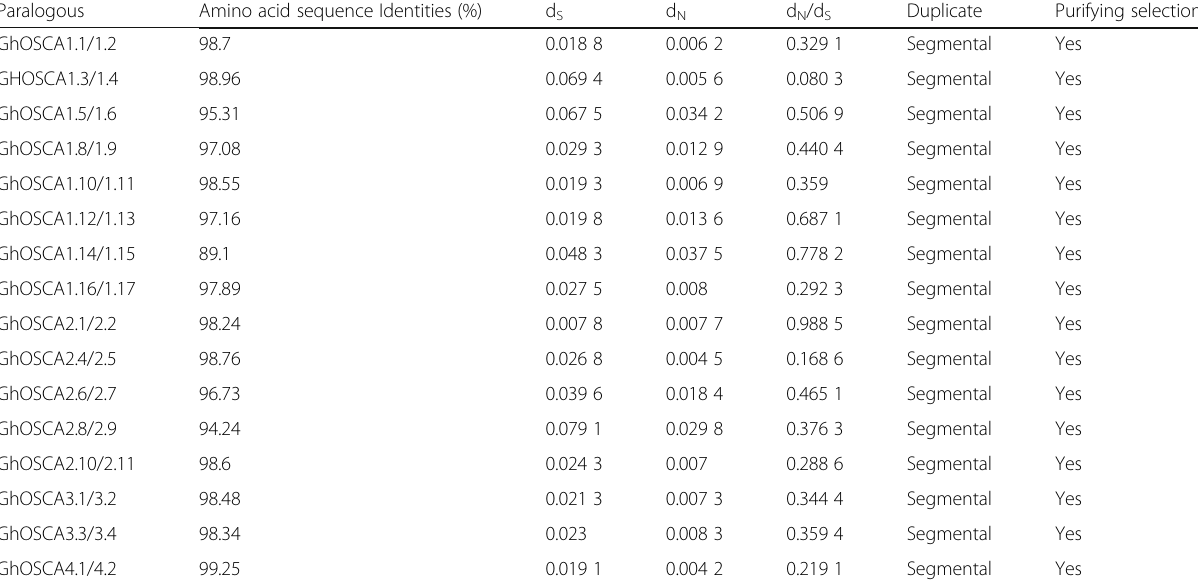
Table 3 The dN/ds values for duplicate GhOSCA genes Paralogous Amino acid sequence Identities (%) d S d N d N /d S Duplicate Purifying selection GhOSCA1.1/1.2